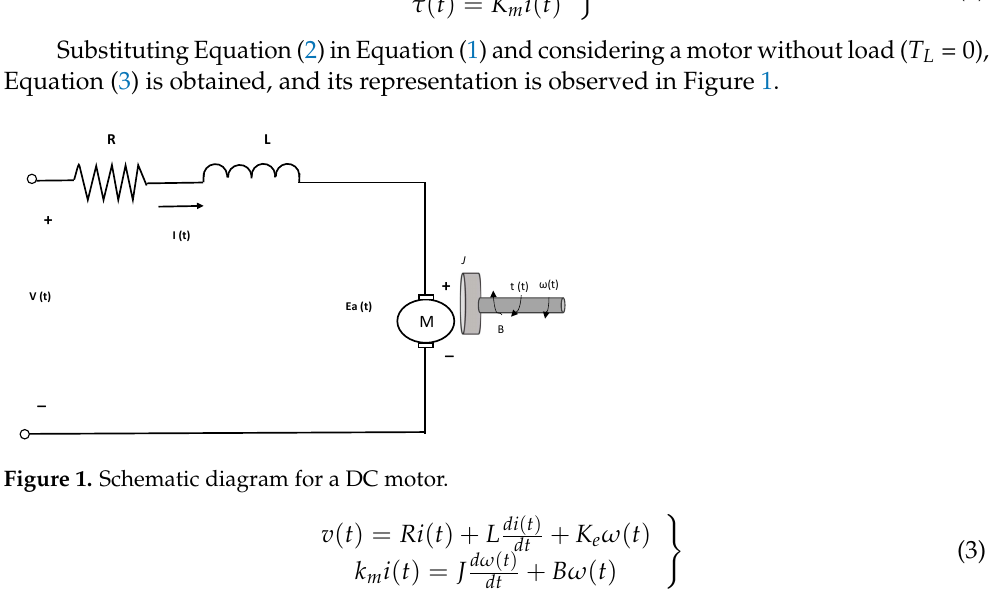
Figure 1:Schematicdiagram for DC motor.